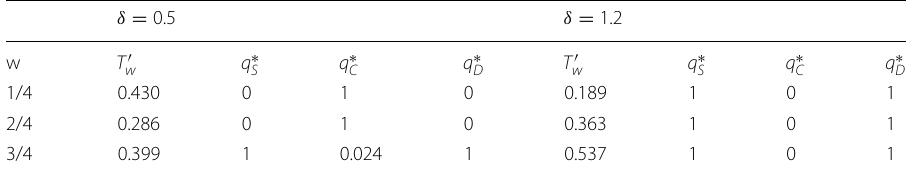
, q ∗ , q ∗ Table 5 The values of q ∗ for which the weighted sum throughput is maximized and the S C D queue at S is unstable for α = 0.7, M U = 200, M D = 1000, and M S = 2000 δ = 0.5 δ = 1.2 w T ′